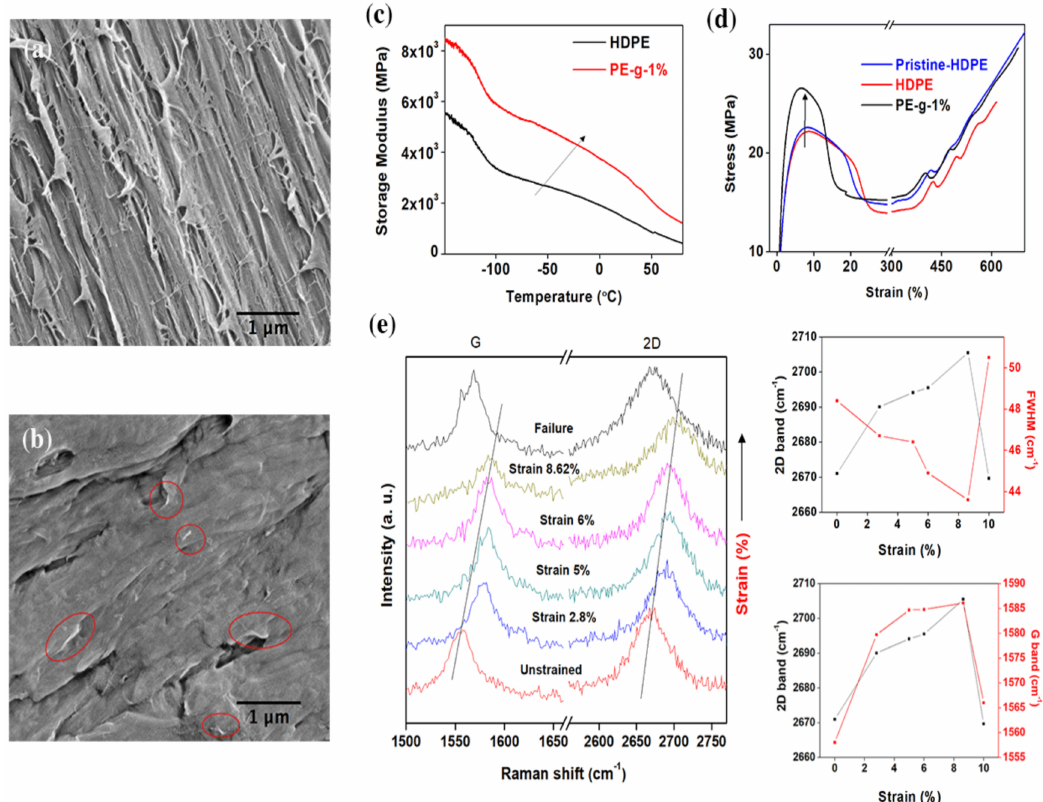
Figure 5. Assessment of the interfacial adhesion strength between graphene sheets and polymer matrix. SEM images of a cross-section fracture surface from ( a ) neat multimodal-HDPE and ( b ) PE-g-1%. ( c ) Dynamic-thermomechanical analysis (DTMA) of the neat multimodal-HDPE and PE-g-1%. ( d ) Tensile stress-strain curves for the pristine multimodal-HDPE (non-extruded), neat multimodal-HDPE (extruded), and PE-g-1%. The pristine polymer is the powder polyethylene. ( e ) Shift with strain of the 2D and G Raman bands of the graphene during deformation upon PE-g-1% nanocomposite (laser excitation energy 2.33 eV). The corresponding 2D and G Raman shifts as a function of applied strain are shown in the two graphs on the